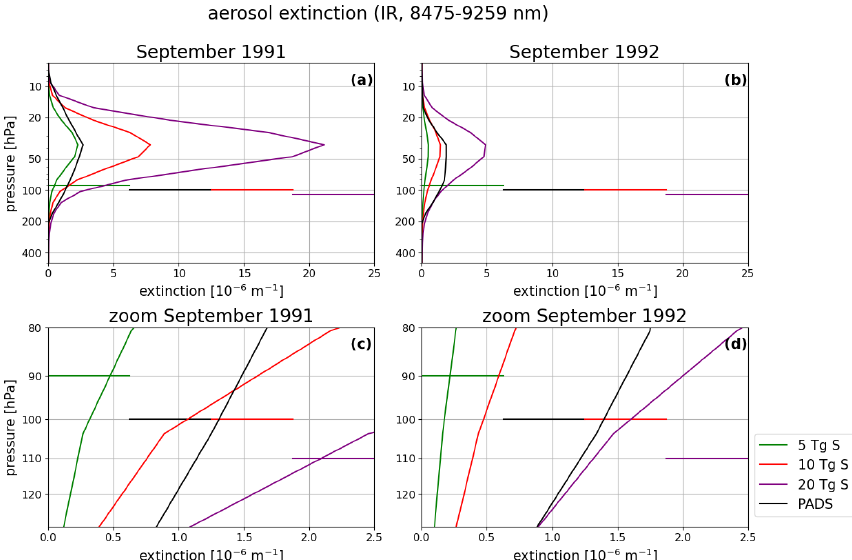
Figure 10. Average tropical aerosol extinction in the 8475–9259nm infrared waveband from EVA for 5, 10 and 20Tg S emissions as well as from PADS in September 1991 and 1992. The horizontal lines indicate the pressure levels of the cold point in the region between [− 5 , 5 ] ◦ latitude for each eruption strength. Panels (a) and (b) show the entire profile. Panels (c) and (d) are zooms of the cold-point